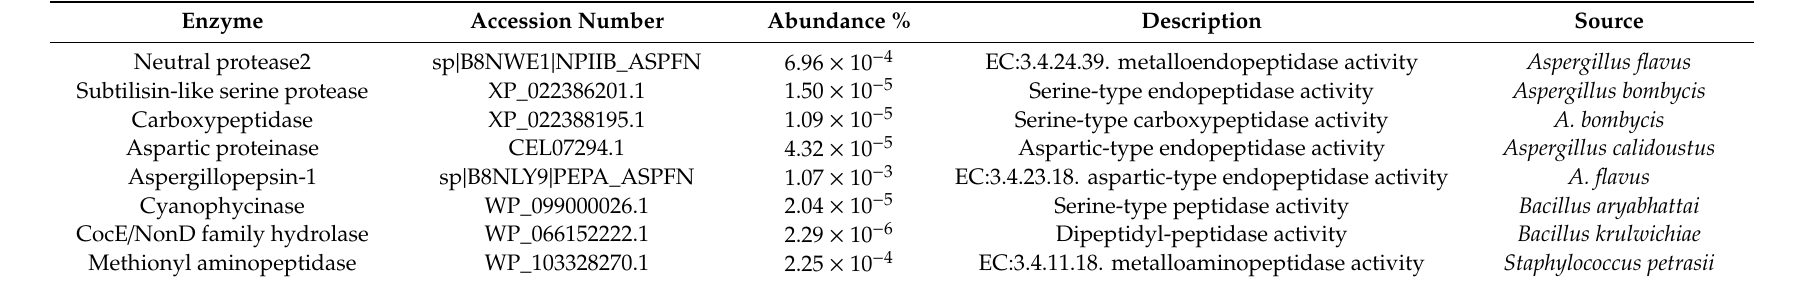
Table 3. Peptidases detected by extracellular